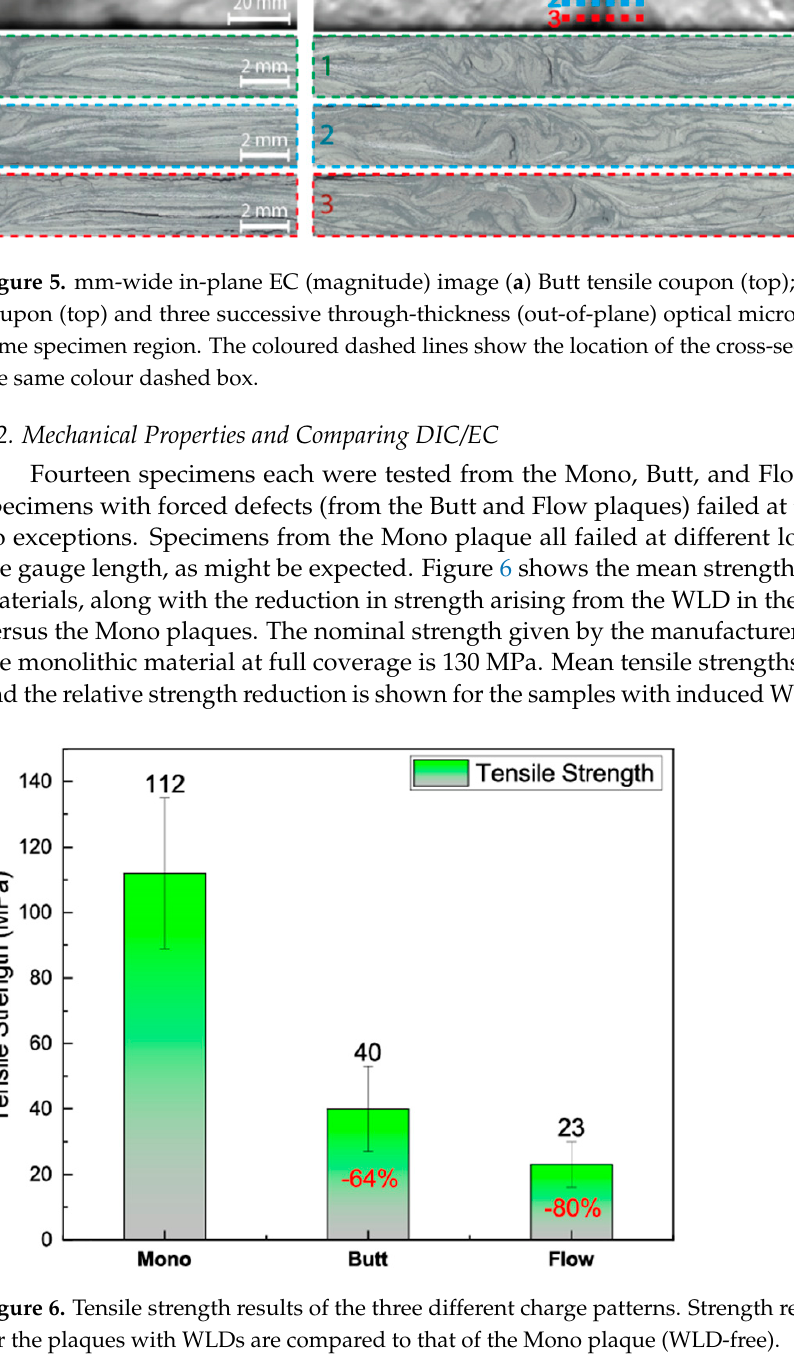
for the plaques with WLDs are compared to that of the Mono plaque (WLD-free).